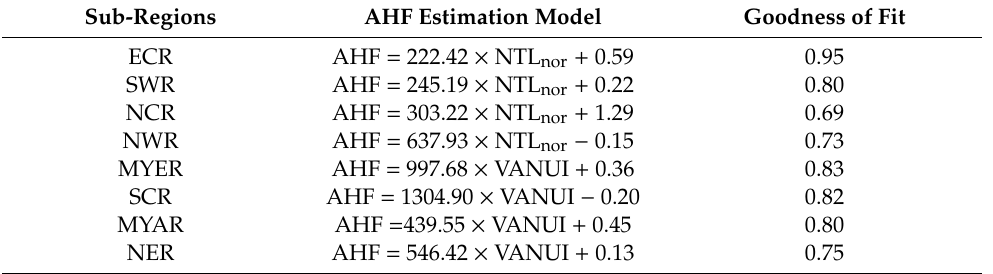
Table 1. The AHF partition estimation model and its goodness of